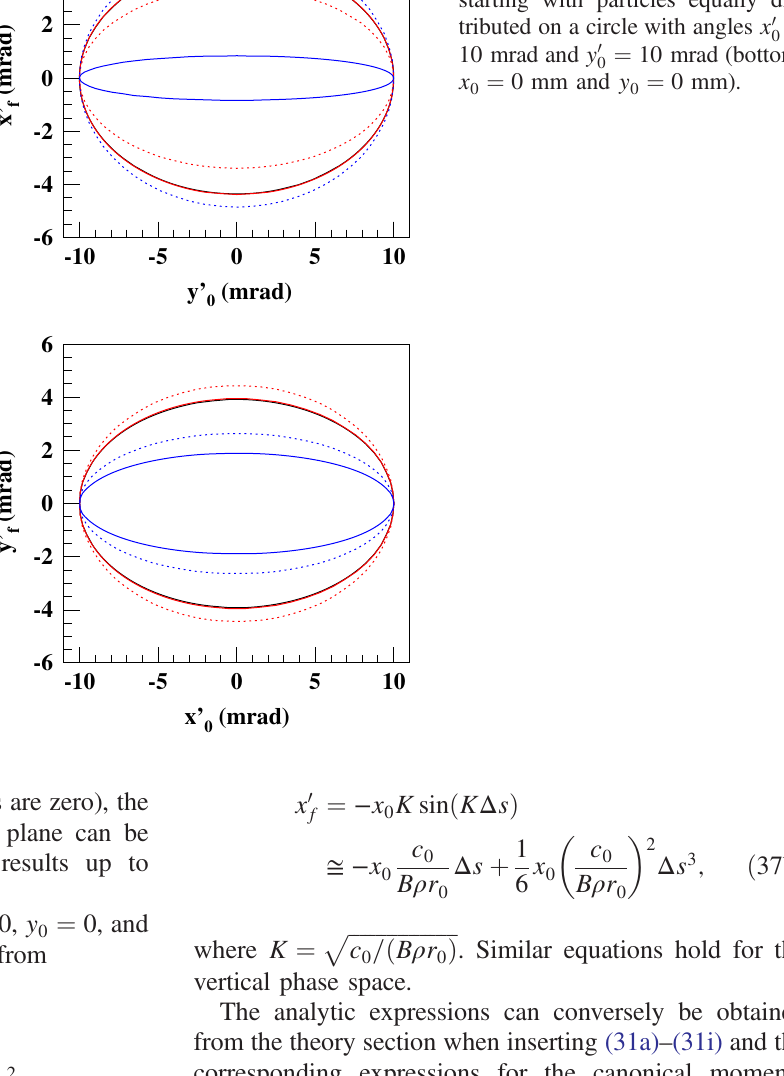
FIG. 7. The same color code and line type as Fig. 4, but with different initial coordinates (see the text): starting with particles equally dis- tributed on a circle with angles x 0 0 ¼ 10 mrad and y 0 10 mrad 0 ¼